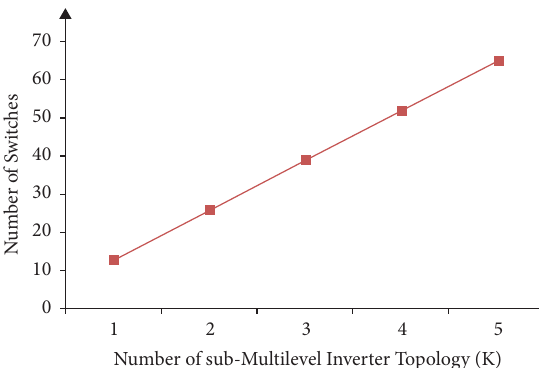
Figure 6: Variation of switching devices with proposed sub- multilevel inverters.